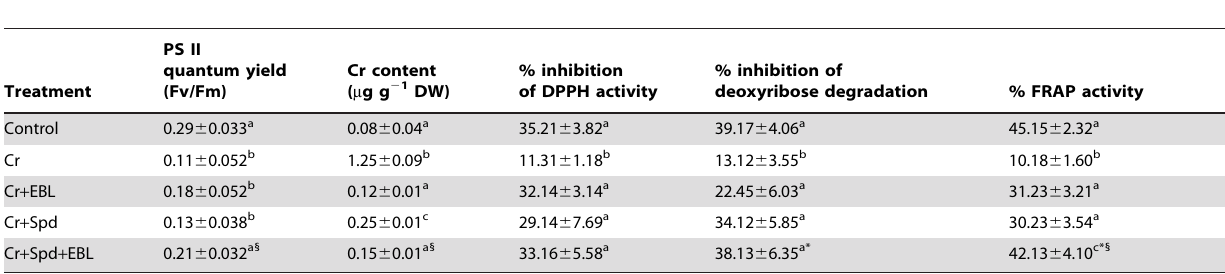
Table 5. Effects of EBL and Spd on PS II quantum yield (Fv/Fm), Cr-uptake and radical scavenging activities in radish seedlings under